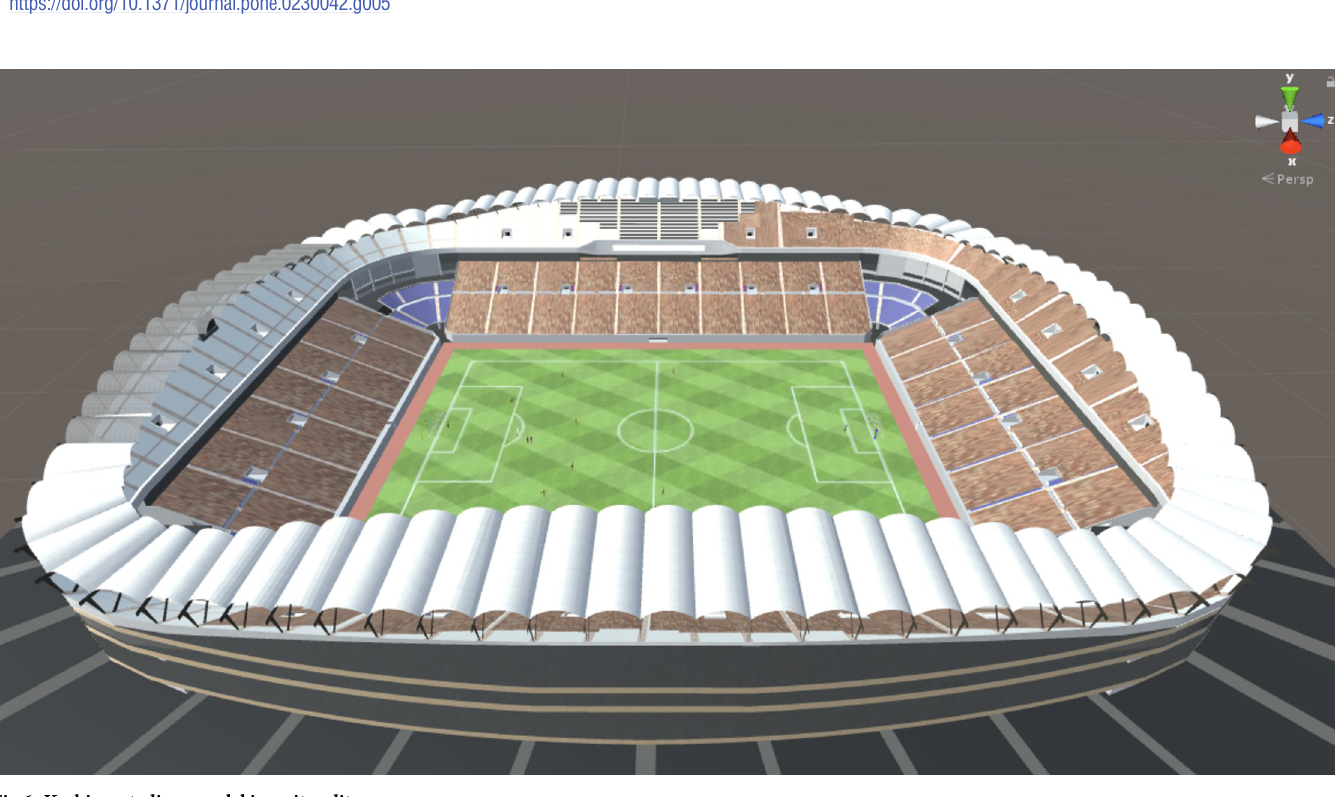
Fig 6. Kashima stadium model in unity editor.